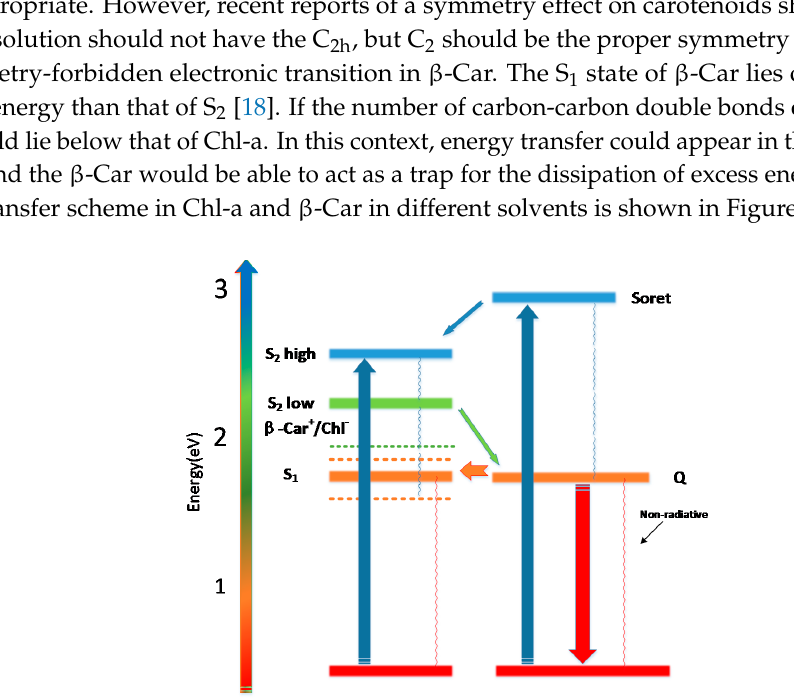
Figure 3. Proposed energy transfer scheme in Chl-a and β -Car in different solvents.